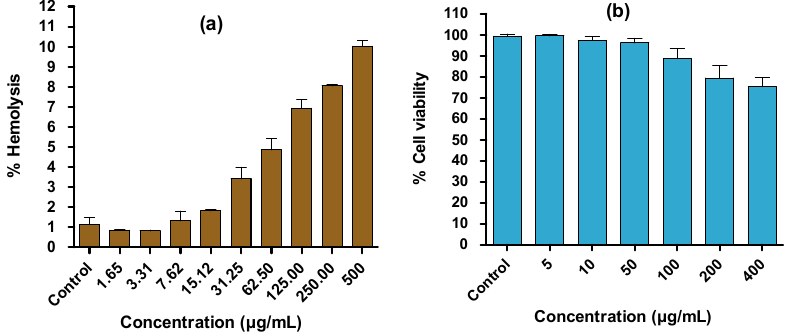
Figure 4. Cytotoxic effect of PS9 ( a ) h RBC and ( b ) HEK293 cells.